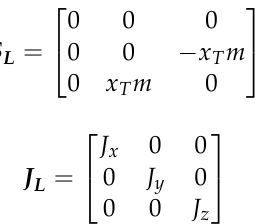
is the tensor of inertia L